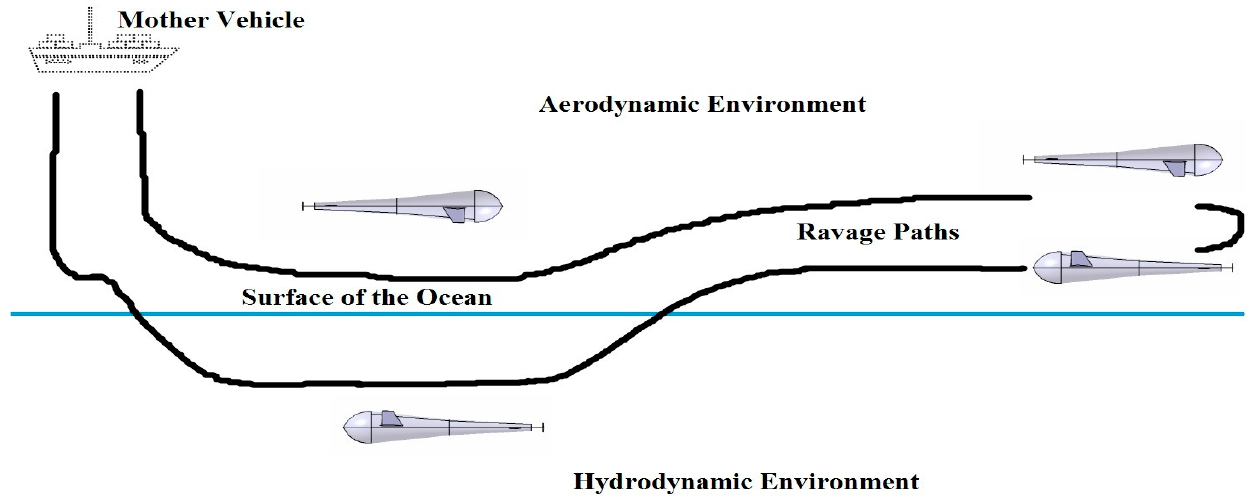
Figure 2. Mission profile of this proposed nature inspired UAV. Table 1. Comparative information about design of unmanned underwater vehicle. Table 5 show the symbols used in this work. Table 5. Symbols and